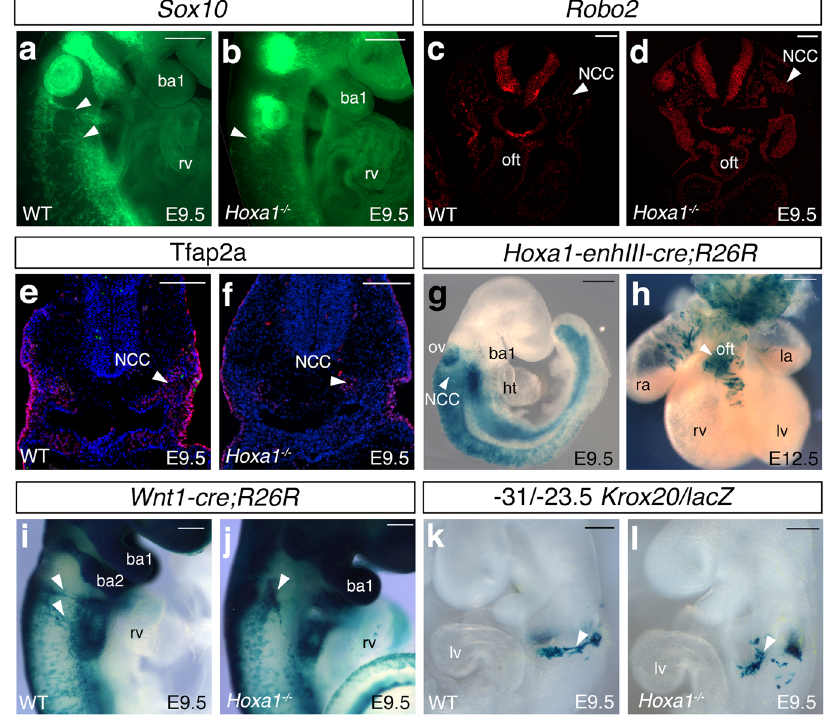
Fig. 7 | Neural crest cell defects in Hoxa1 null mice. a , b RNA-FISH showing the expression of Sox10 (green) in wild-type (WT) ( a ) and Hoxa1 − / − ( b ) E9.5 embryos. Lateral view of Sox10 staining revealed a decrease of expression in the migrating neural crest cells (arrowheads). c, d , RNA-FISH showing Robo2 expression (green) in wild-type ( c ) and Hoxa1 − / − ( d ) E9.5 embryos. Expression of Robo2 is higher in Hoxa1 − / − thanwild-type littermates. e , f Cross-sections ofwild-type ( e ) and Hoxa1 − / − embryos ( f ) immunostained with anti-Tfap2-alpha antibody (red). Note the reduc- tion of Tfpa2-alpha positive cells in the mutant (arrowhead). g , h Hoxa1 -lineage visualized by X-gal staining of Hoxa1-enhIII-cre;R26R-lacZ embryos. g , Lateral view showing β -galactosidaseactivityinmigratingneuralcrestcells(NCC;arrowhead)in